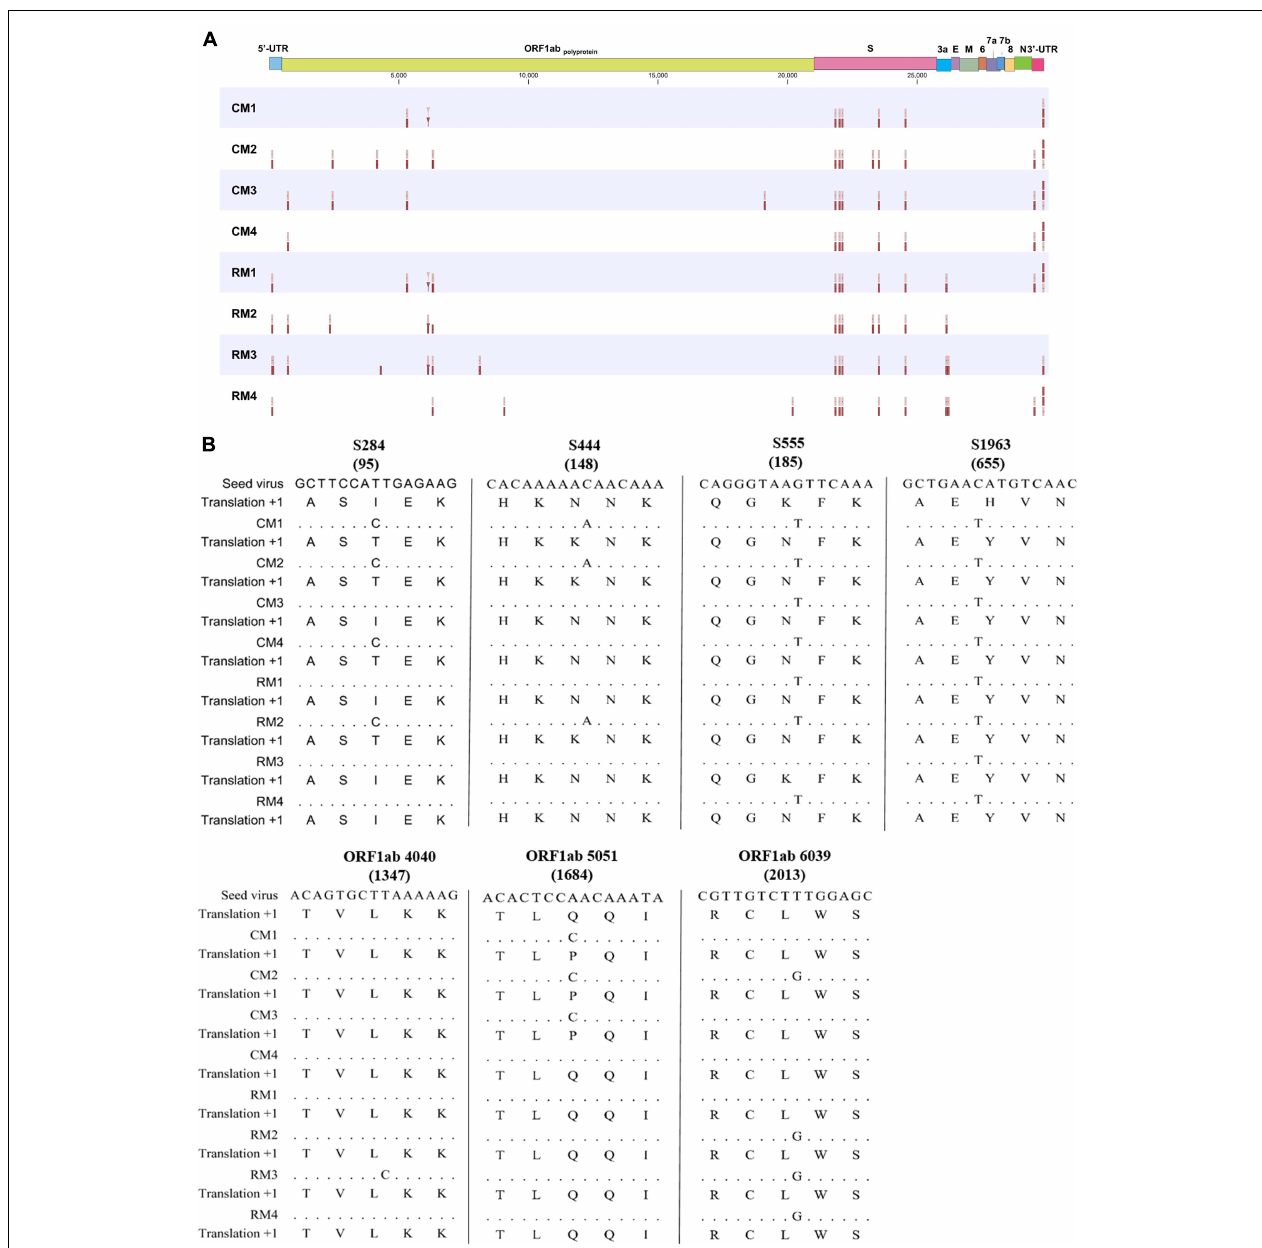
FIGURE 4 | Variant profiles within the whole SARS-CoV-2 genome. (A) Interhost variants in single nucleotide variants and (B) consensus sequences of the seed virus and SARS-CoV-2 isolates. The number in parenthesis indicates amino acid position.